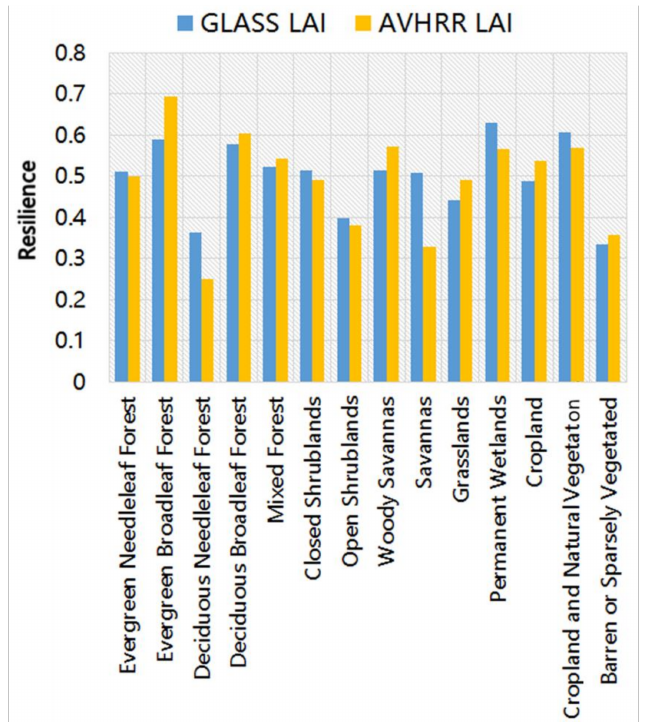
Figure 6. Terrestrial resilience in di ff erent land-cover types. The bars represents the mean terrestrial resilience in di ff erent land cover